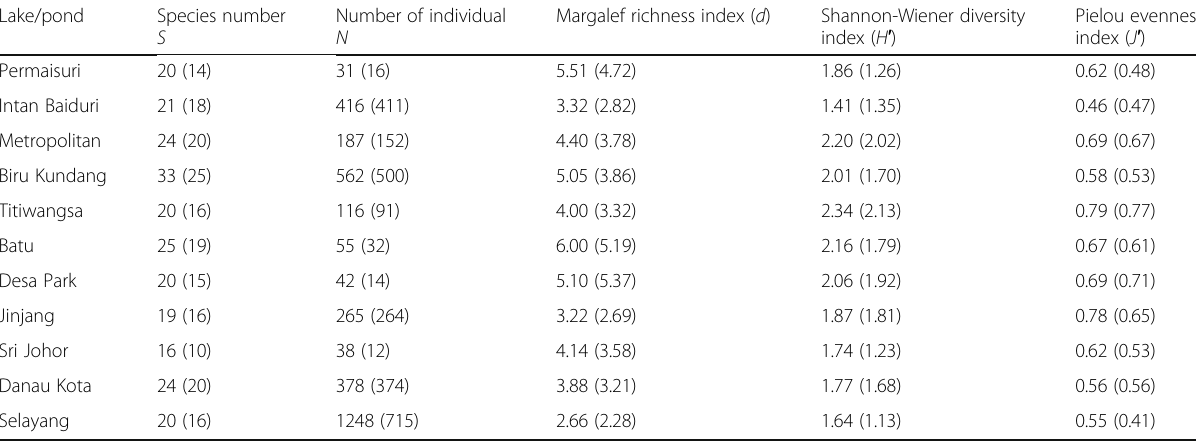
Table 2 Biodiversity index of zooplankton in studied ponds and lakes. Item in parentheses represents rotifer diversity Lake/pond Species number